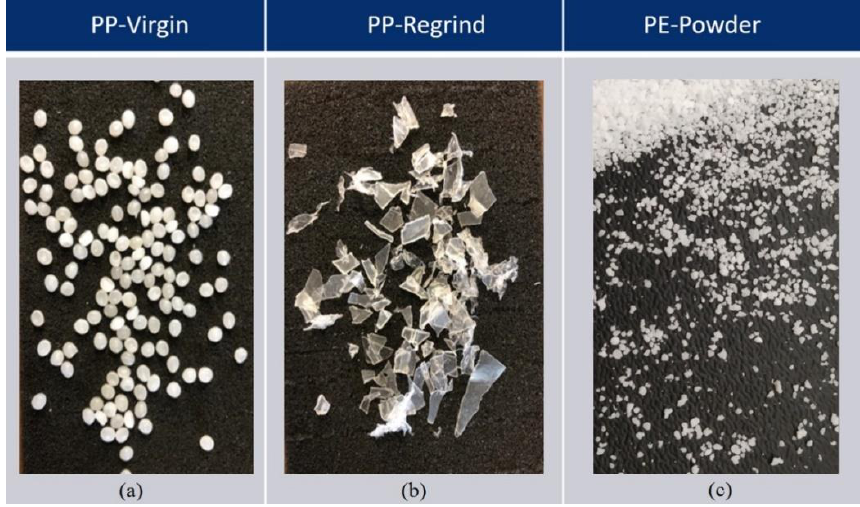
Figure 3. Pictures of ( a ) the virgin PP granule ( b ) the regrind PP ( c ) the powdery PE. The projected area of the virgin granule and of the regrind material was determined using a flatbed scanner Perfection V850 Pro from the company Seiko Epson Corporation, Suwa, Nagano, Japan. The two-dimensional scans were quantitatively analyzed using the open-source software Fiji ImageJ . It was necessary to manually separate individual particles on the scanner surface in order to obtain a proper